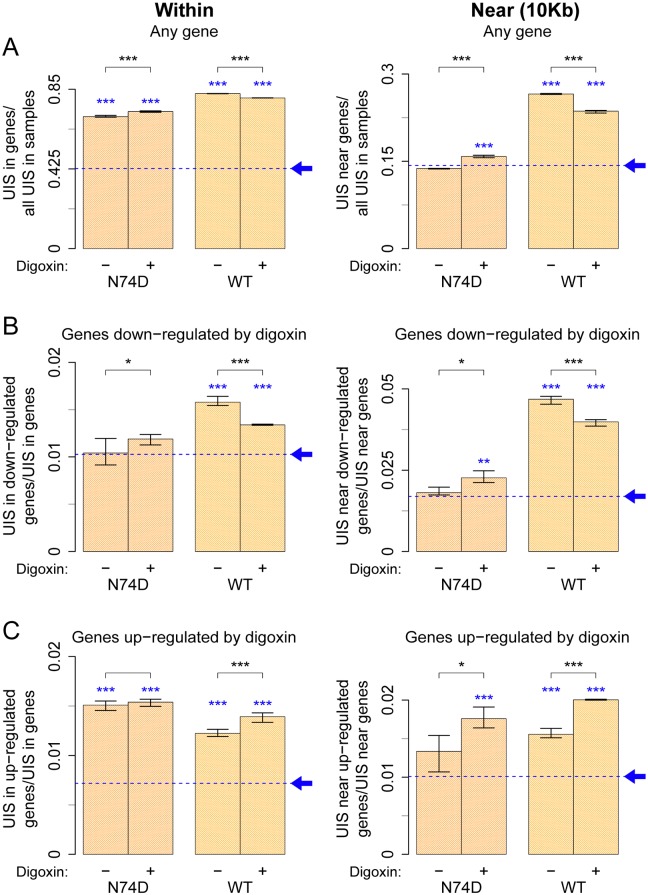
WT HIV-1 integrates more frequently within or near genes that are susceptible to down-regulation by digoxin.Three separate aliquots of Jurkat cells were independently infected with single cycle VSV-G pseudotyped HIV-1 LAIΔenv WT or N74D at an MOI of 0.2 in the presence of DMSO or 400nM digoxin. Thirty-six hours later, DNA was extracted and integration sites were identified and quantified. Same analysis was carried out for a dataset of random integration sites generated in silico, sampled from a gap-excluded reference of the human genome (hg19). This matched random control is shown as a blue dashed baseline, pointed by an arrow. (A) Plots for integration of HIV-1 WT and N74D within (left panel) or near (within 10kb of start site) (right panel) known genes. (B) Plots for integration of WT and N74D virus within (left panel) or near (right panel) genes susceptible to down-regulation by digoxin relative to their baseline bias to integrate within or near any gene. (C) Same as (B) but plots show integration within (left panel) or near (right panel) genes susceptible to up-regulation by digoxin. Each bar shows an aggregate result from all three replicates, with the range of results for the individual replicates shown by the whiskers. Black asterisks above bar graphs denote statistical significance between control (DMSO) and digoxin-treated samples. Blue asterisks just above the bar graphs denote statistical significance in the samples relative to baseline (same analysis carried on the in silico sites) and was assessed using the Fisher’s exact test with Bonferroni’s correction for multiple comparisons (* < 0.05, ** < 0.01, *** < 0.001).